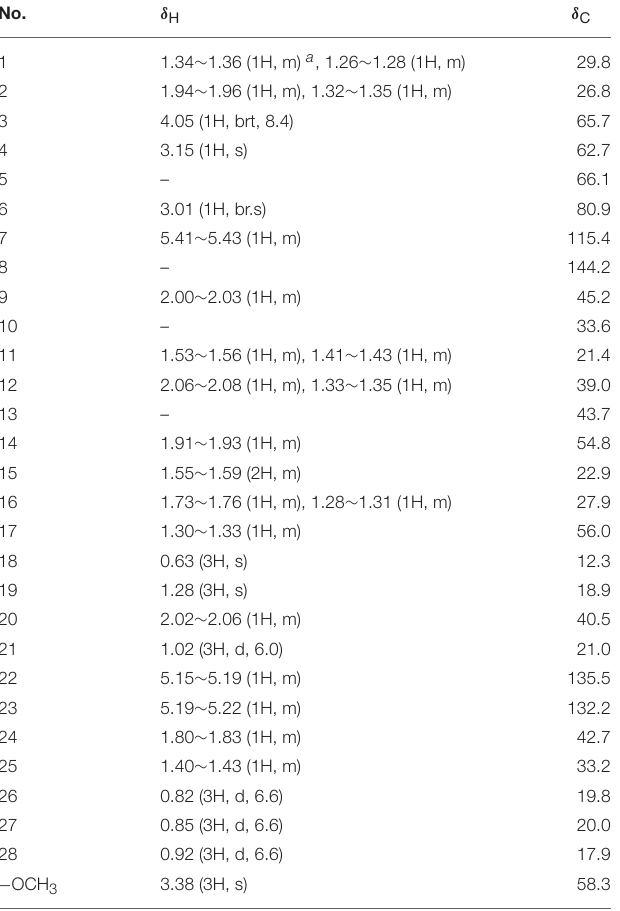
TABLE 1 | 1 H and 13 C NMR spectral data of compound 1 in CDCl 3 ( 1 H for 600 MHz, 13 C for 150 MHz).